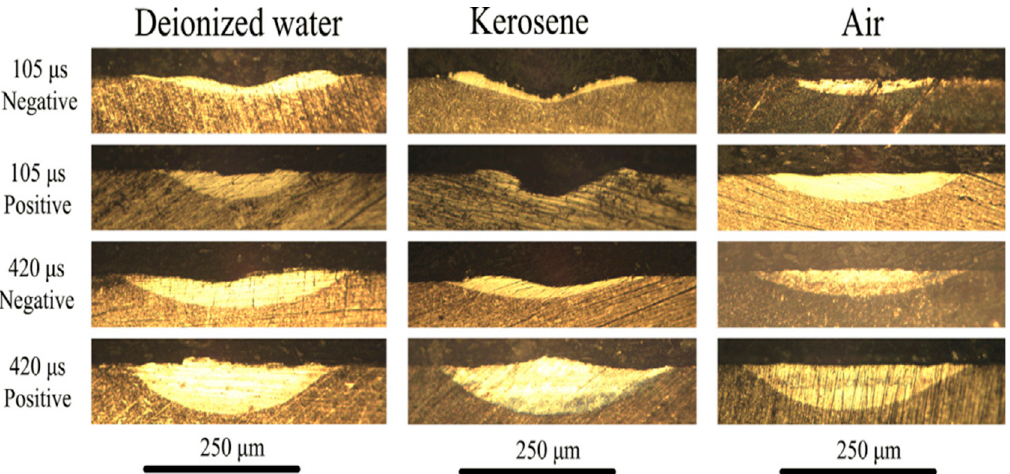
Figure 11. Comparison of the section view of the craters obtained using different dielectrics and polarities [197].